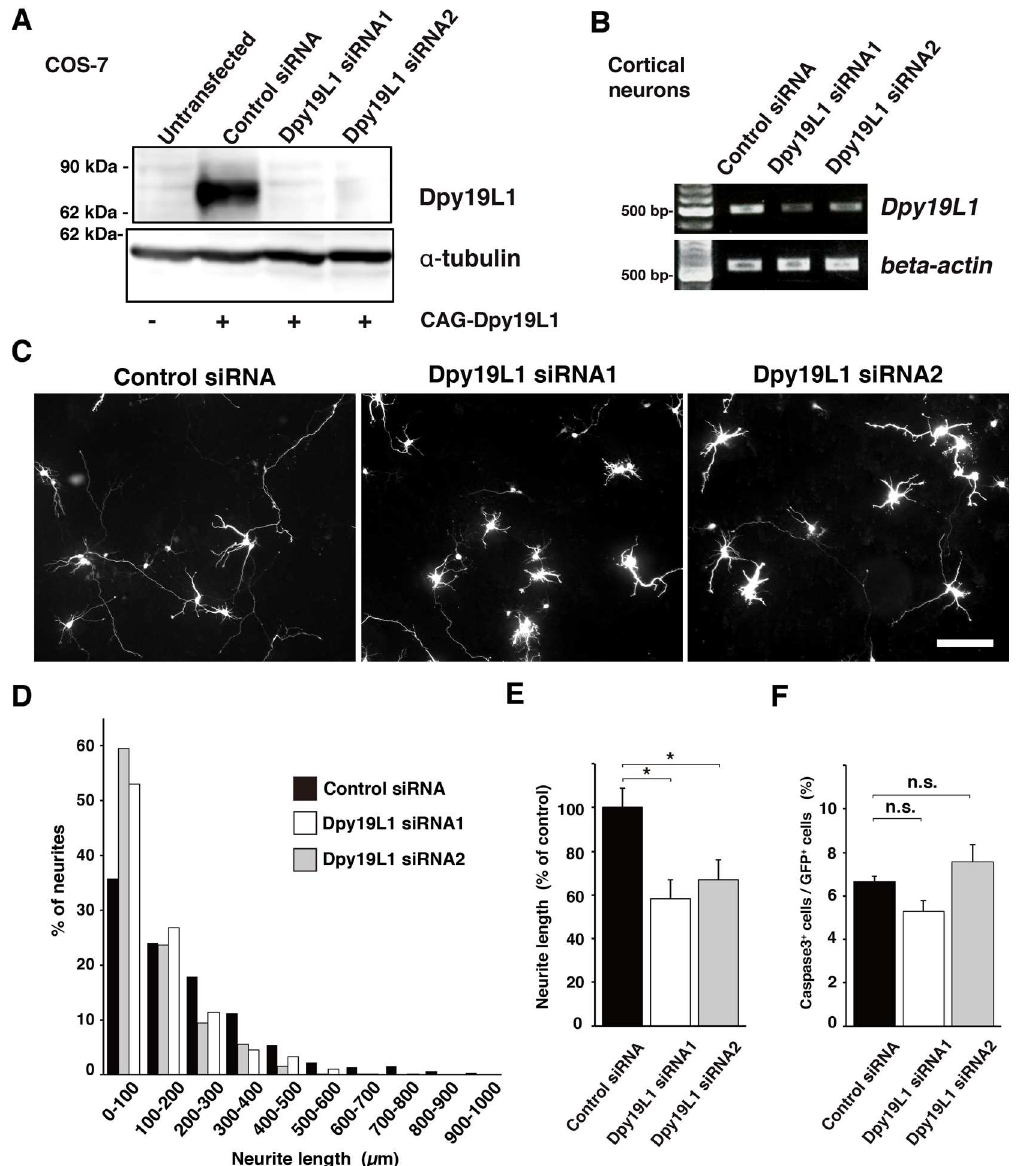
Fig 5. Requirement of Dpy19L1 in neurite extension of cortical neurons. (A) COS-7 cells were transfected with either a Dpy19L1 siRNA or control siRNA alongwith a CAG-Dpy19L1 expressionplasmid, followedby western blot analysisat 48 h after transfection. Dpy19L1expressionwas efficiently reducedby Dpy19L1downregulation. α - Tubulinwas used as a control. (B) Either control siRNA or one of two Dpy19L1siRNAs was transfected in embryonic cortical neurons, and 48 h later, the expressionlevel was checked by RT-PCR. Each Dpy19L1siRNA decreased Dpy19L1 expression. β -actin was used as a control. (A, B) The blots (A) and the gels (B) were croppedfrom the same gels, and the full-lengthblots and gels are shown in S5B and S5A Fig, respectively. (C − E) E14.5 cortical neurons were transfected with control or Dpy19L1siRNA and allowedto differentiate for 72 h. The lengthsof the longest neurite were comparedbetweencontrol and Dpy19L1-downregulated neurons. Dpy19L1-downregulated neurons show reducedneurite length comparedwith that of control neurons. Scale bar: 100 μ m. (D) Histogramshows distribution of neurite lengthsof control and Dpy19L1-downregulated neurons.(E) Average neurite lengthof control siRNA and Dpy19L1siRNA transfected neurons. (F) Comparisonof the number of cleavedCaspase3-labeledcells betweencontrol and Dpy19L1-downregulated neuronsat 48 h after transfection. All data shown here are from at least three independent culture experiments. Values are mean ± SEM. * P < 0.05.